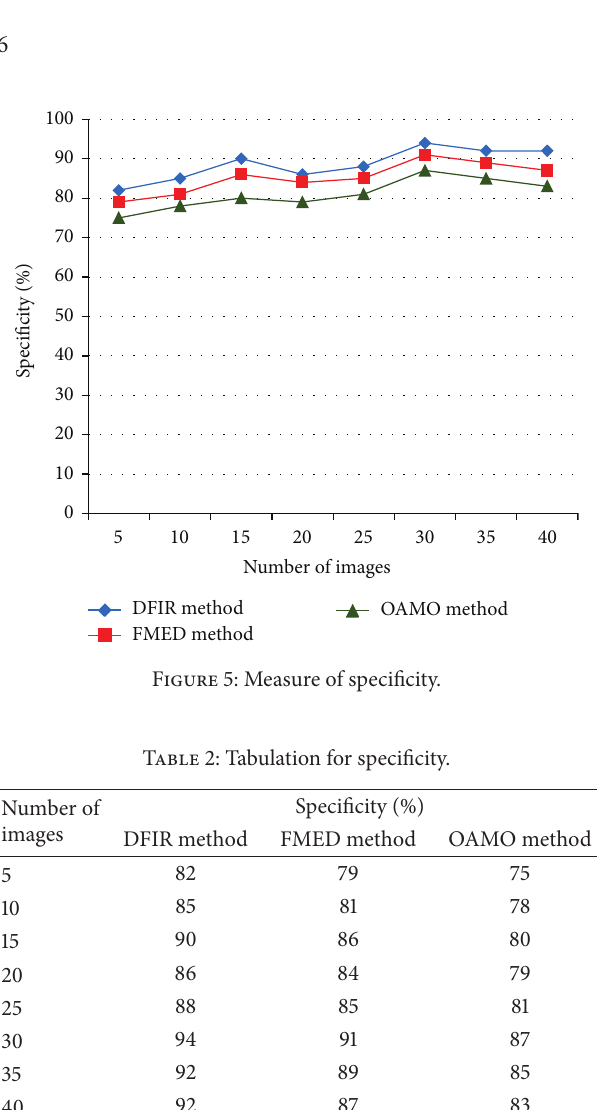
Figure 6: Measure of ranking